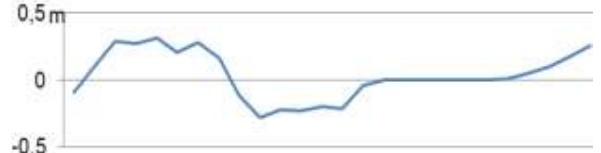
Figure 21. Systematic Z-discrepancies of WorldView-4 DSM as function of Y